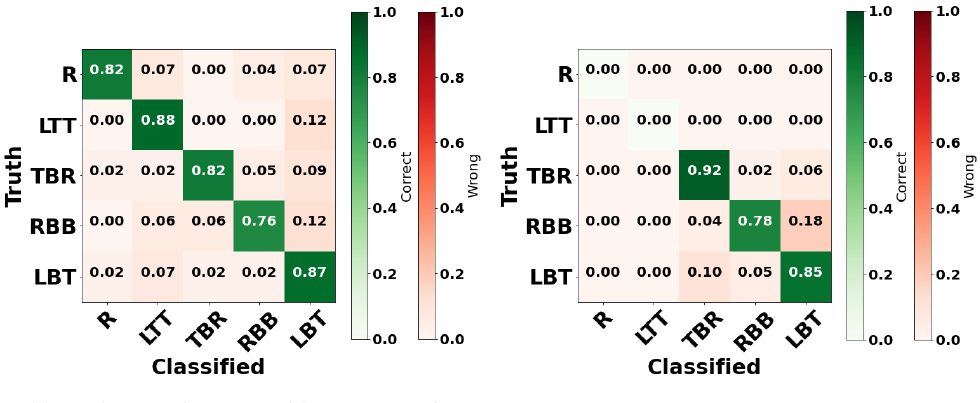
Figure 14. Normalized confusion matrices for the CombinedOUTER-CNN tests: ( a ) the per-state performance of the self-test and ( b ) the per-state performance of the test at the data of the Gold Coast with the outer bar